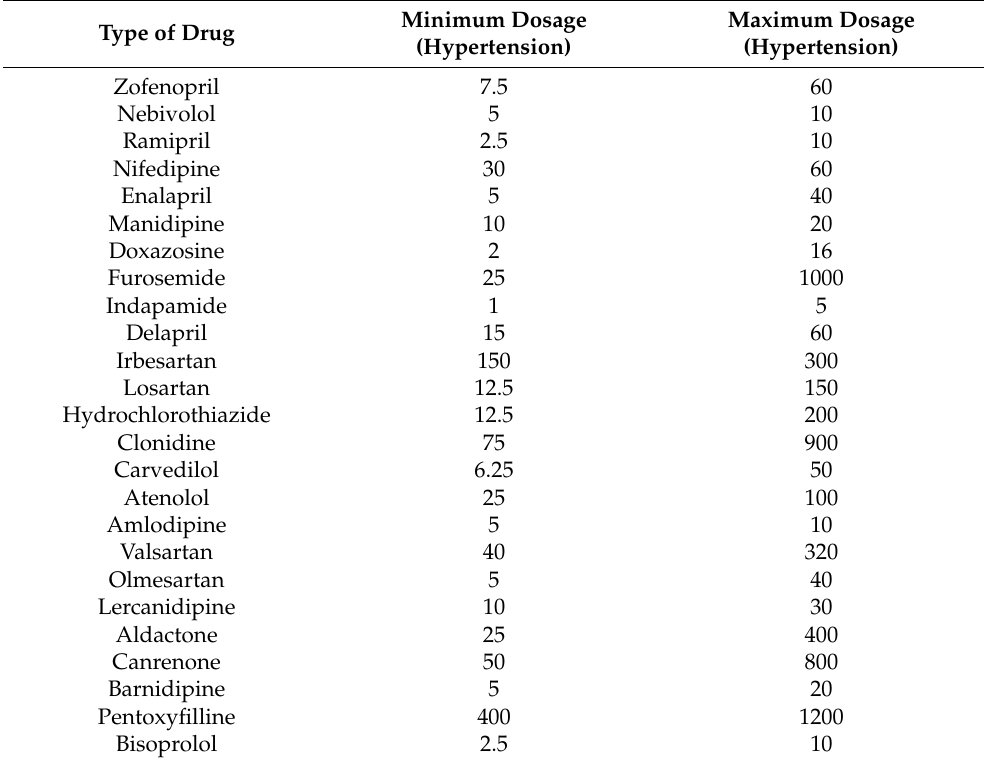
Table 1. List of preoperative drugs used in the cohort for the TIS score